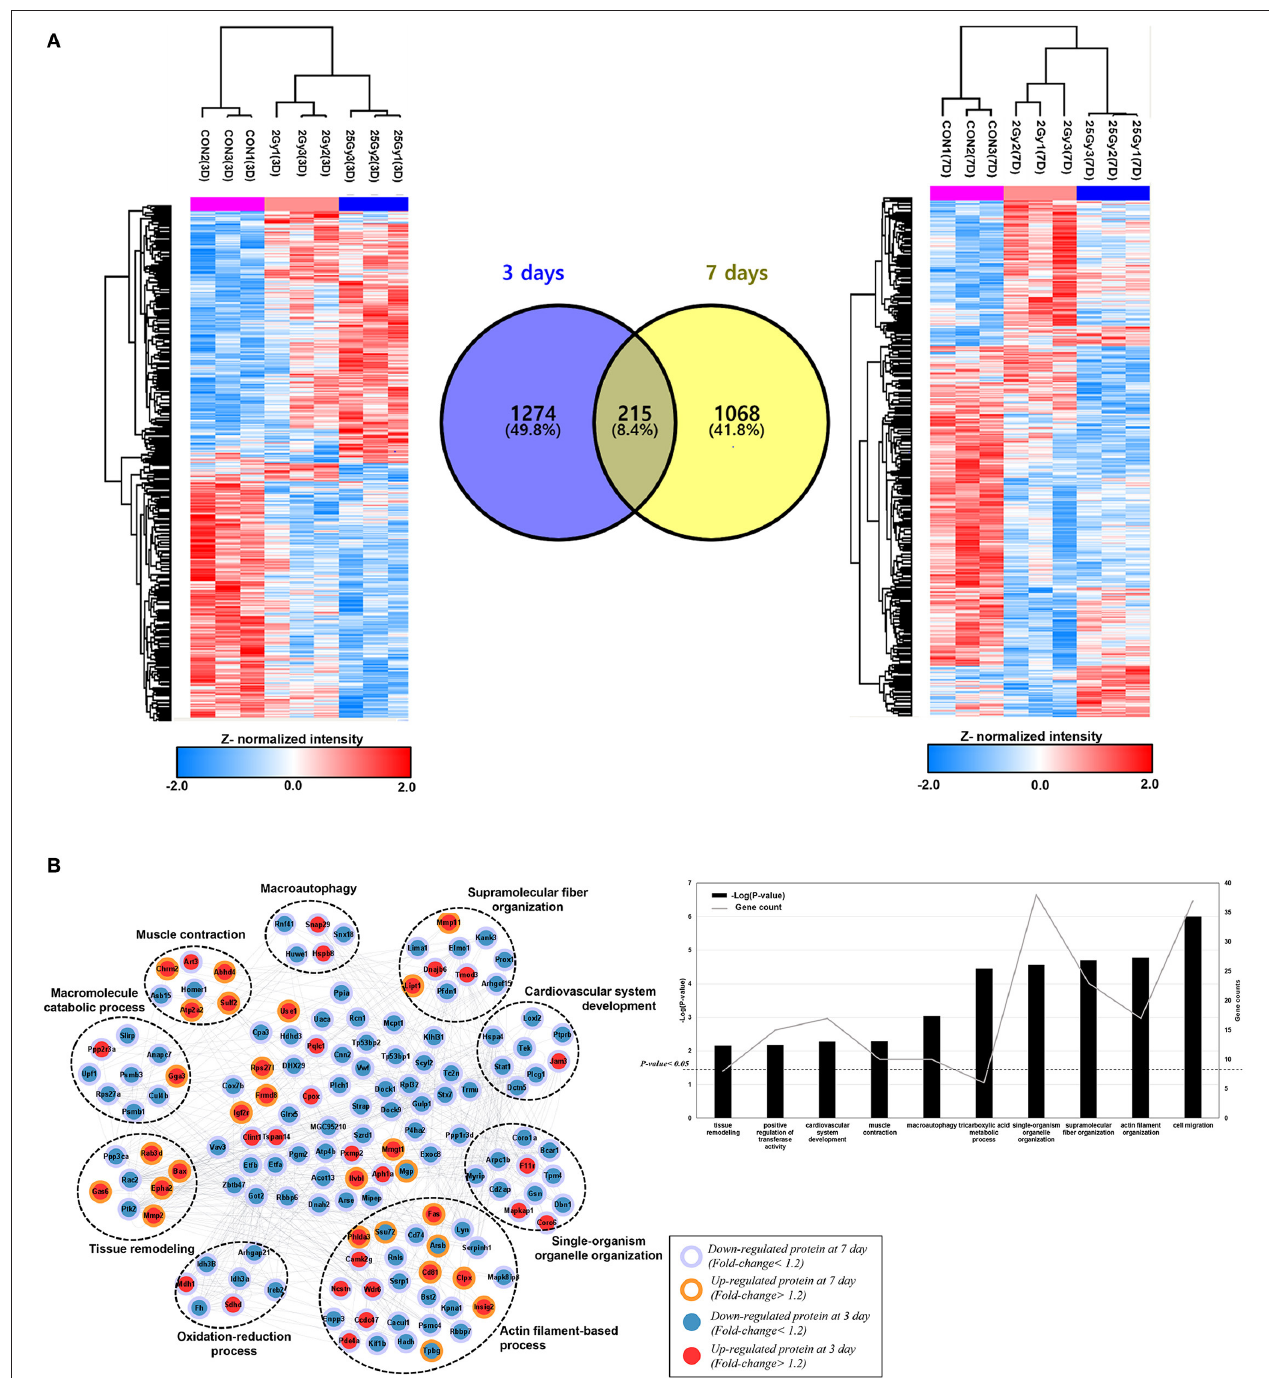
FIGURE 1 | The hierarchical clustering of differentially expressed cardiac proteome induced by single high-dose irradiation. (A) Overall ANOVA results at day 3 and day 7. The DEPs were filtered with P -value lower than 0.05 and Z-normalized for visualization. The result identified 1,489 and 1,283 DEPs at day 3 and day 7, respectively. The Venn diagram presented the 215 common DEPs. (B) PPI (protein-protein interaction) analysis of common DEPs, presented with functional enrichment ( P -value < 0.05) from GO analysis. The filled node presents protein expression from day 3 and the barrier of node presents protein expression from day 7. The list of identified functional process is also displayed as bar